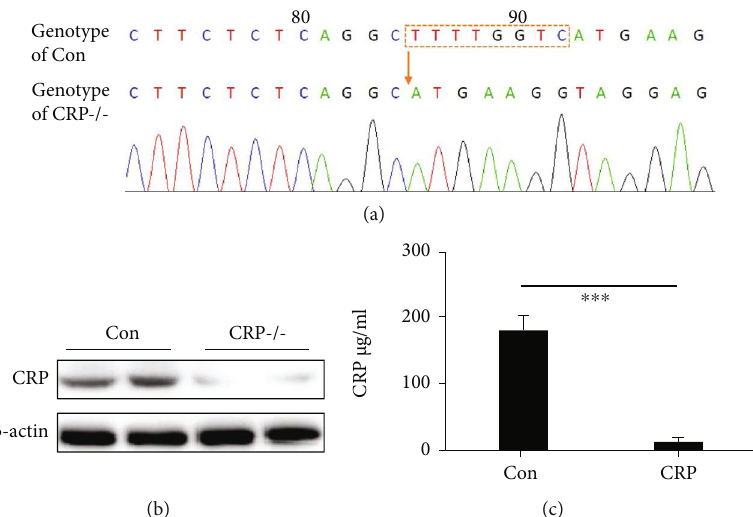
Figure 2: Identi fi cation of CRP knockout in rats. (a) Sequencing chromatogram of CRP -/- rats. The bases in orange box missed in CRP -/- rats. (b) CRP protein expression of hepatic tissue (each protein with 2 parallels). (c) Serum CRP level between control and CRP group ( N = 4 ; mean + SD ; ∗∗∗ p < 0 : 001